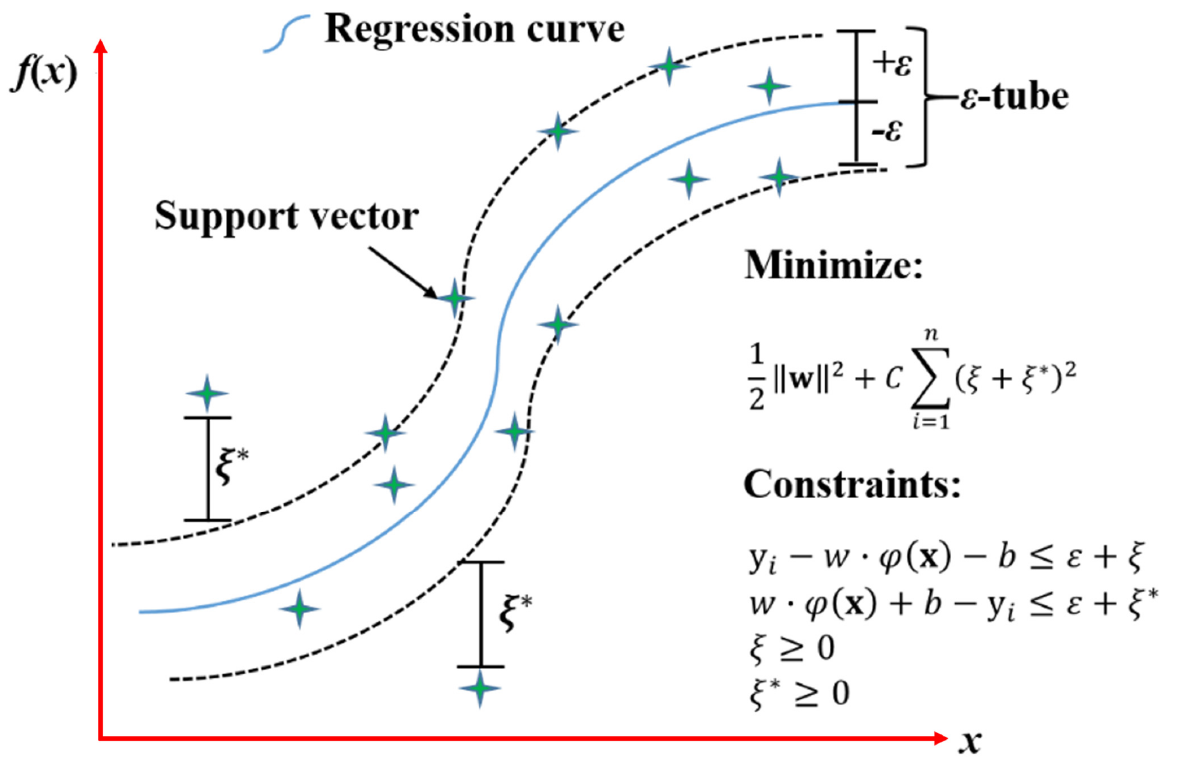
Figure 5. Example of nonlinear SVR with ε -tube.